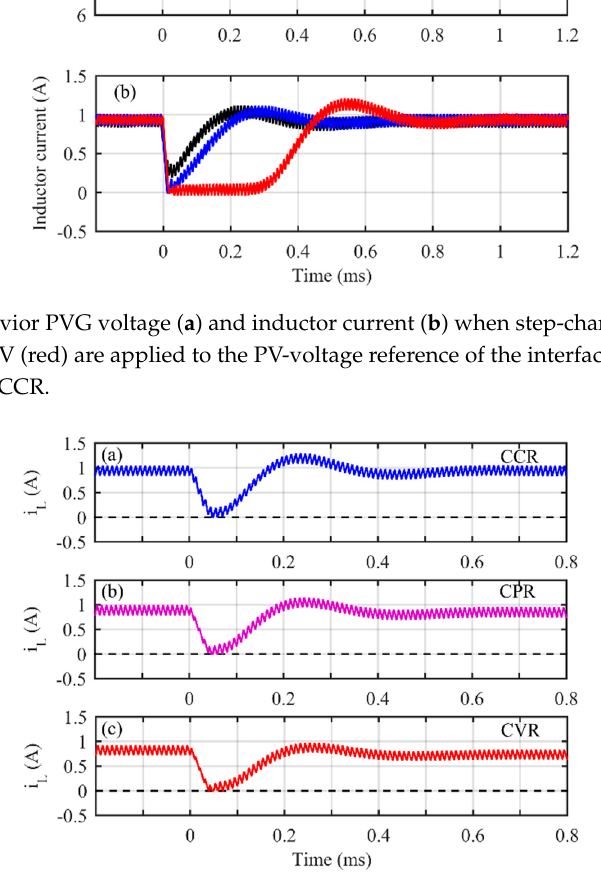
Figure 14. The behavior inductor current when step-changes of 0.71 V is applied ( a ) in CCR, ( b ) in CPR, and ( c ) in CVR.